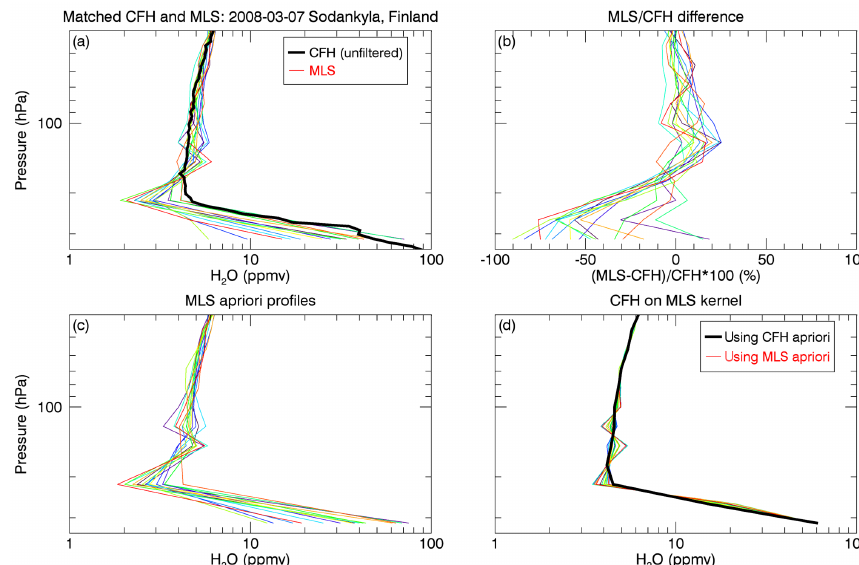
Figure A1. (a) Cryogenic Frost Point Hygrometer (CFH) H 2 O profile (black) taken from Sodankyla, Finland (67 ◦ N), on 7 March 2008, along with the 15 closest-matched Aura Microwave Limb Sounder (MLS) H 2 O profiles (colored). (b) The difference between the matched MLS profiles and the CFH data. (c) The MLS a priori profiles corresponding to the MLS H 2 O retrieval values shown in the upper left panel. (d) The CFH data averaged to the MLS resolution using different a priori profiles as input to the procedure described by Read et al. (2007). The black line is based on the CFH as the a priori, whereas the colored lines are the result of using the corresponding colored line from the lower left